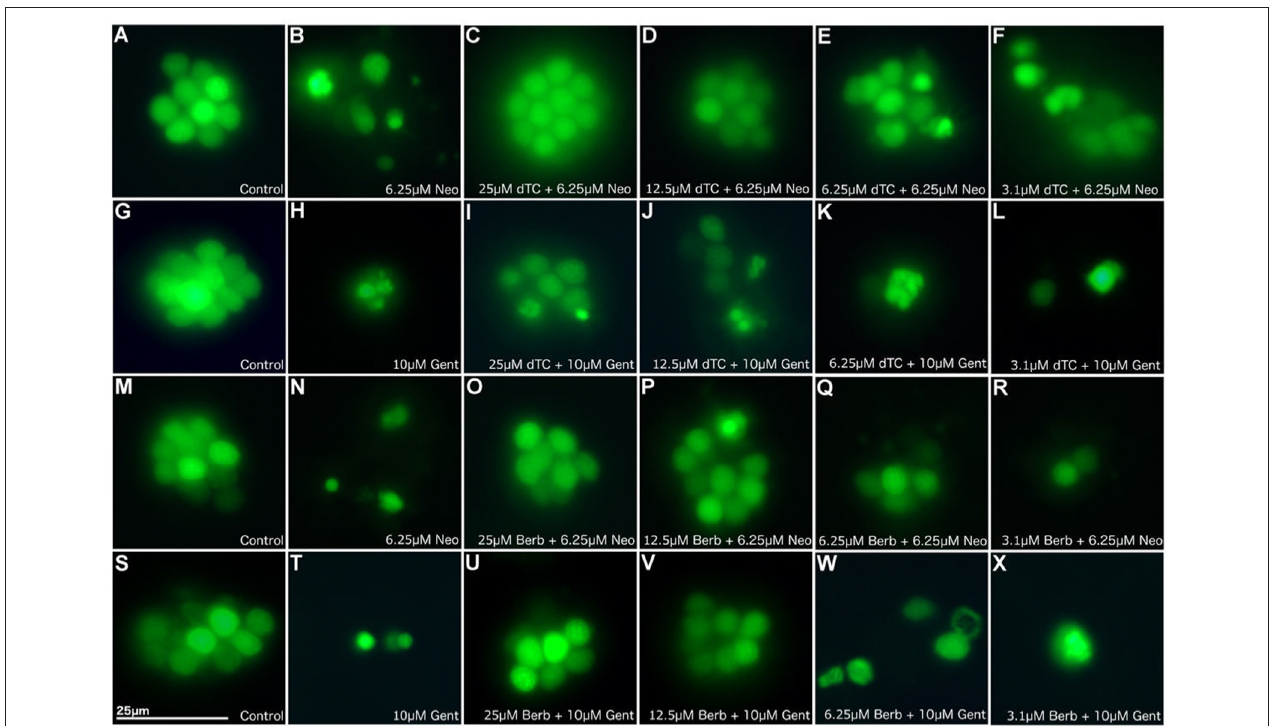
FIGURE 1 | d-Tubocurarine and berbamine protect lateral line hair cells in zebrafish from gentamicin and neomycin induced damage. Zebrafish were treated with: (A,G,M,S) E3 alone (B) 6.25 µ M neomycin, or (C–F) 25, 12.5, 6.25, or 3.1 µ M of dTC plus 6.25 µ M neomycin, (H) 10 µ M gentamicin, (I–L) 25, 12.5, 6.25, or 3.1 µ M of dTC plus 10 µ M gentamicin, (N) 6.25 µ M neomycin, (O–R) 25, 12.5, 6.25, or 3.1 µ M of berbamine plus 6.25 µ M neomycin, (T) 10 µ M gentamicin, (U–X) 25, 12.5, 6.25, or 3.1 µ M of berbamine plus 10 µ M gentamicin. Neuromasts were pre-stained with 3 µ M Yo-Pro1. n > 3 independent experiments with at least 3 fish per well. Images were obtained with a 40X objective. Scale bar = 25 µ